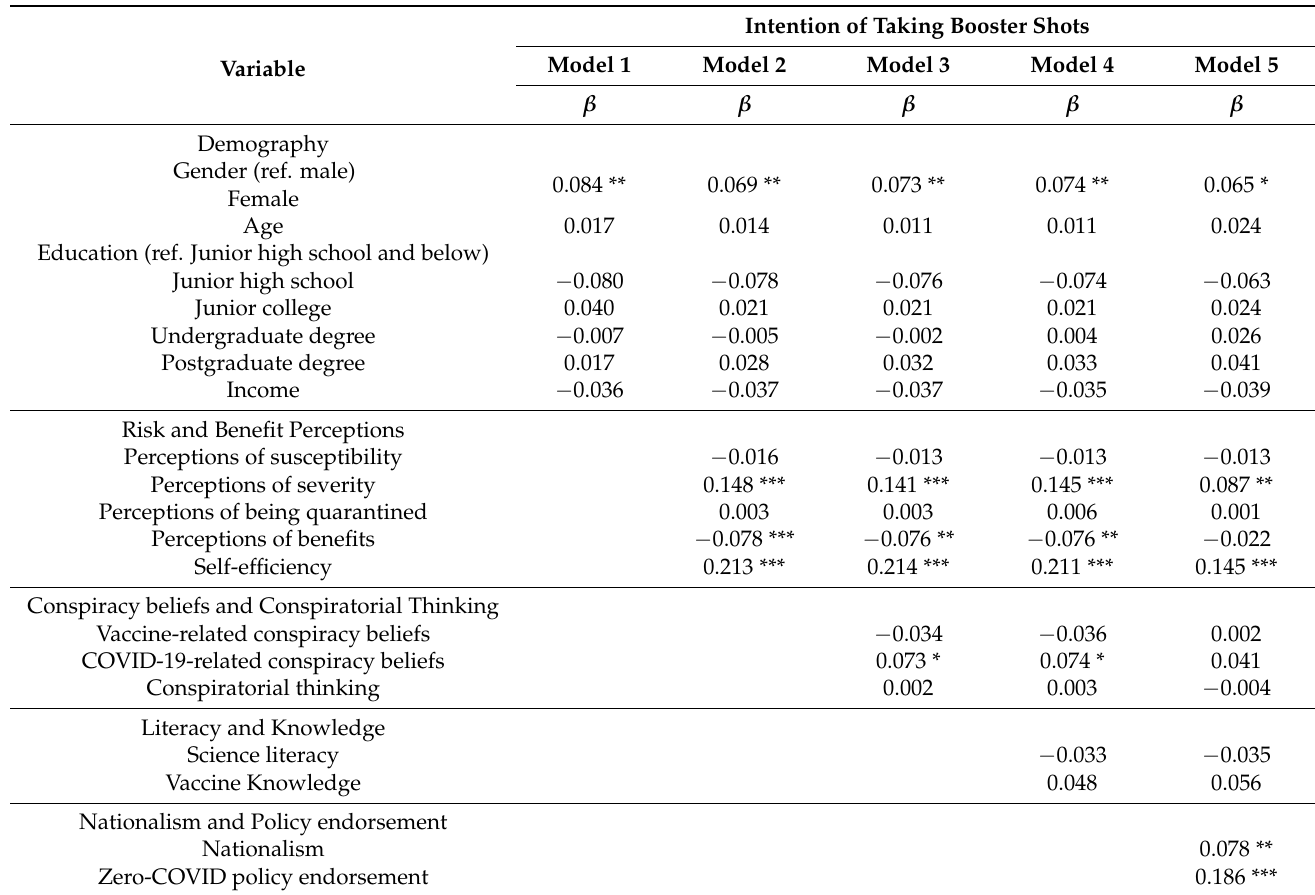
Table 11. Factors associated with the intention of taking booster shots ( n =